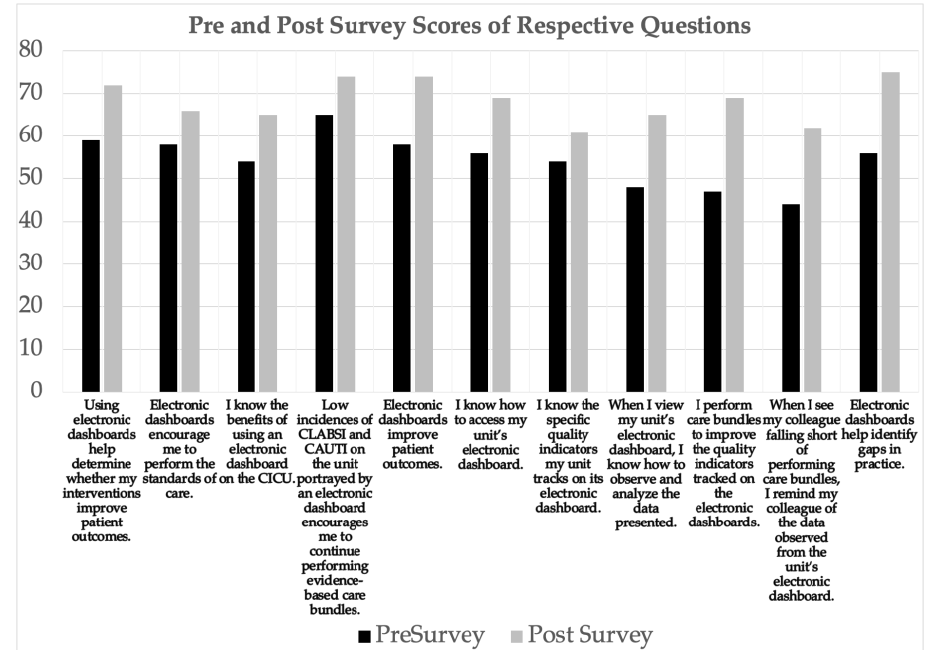
Figure 2. Measurement of respective question scores.